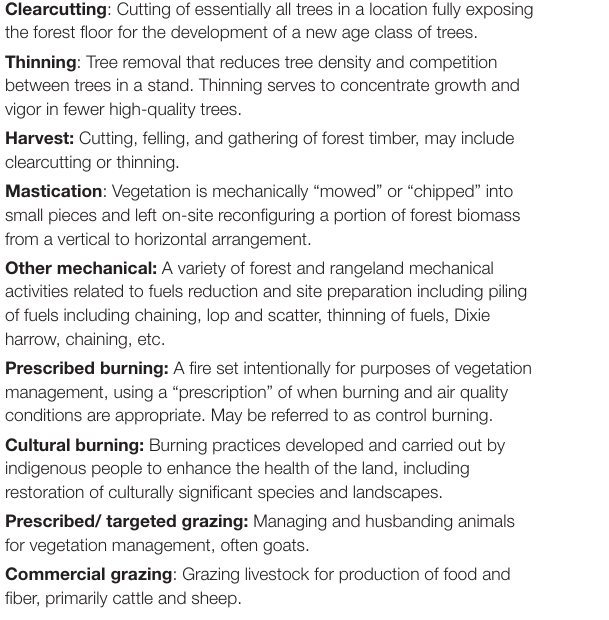
TABLE 1 | Definitions of common vegetation treatments in California. Clearcutting : Cutting of essentially all trees in a location fully exposing the forest floor for the development of a new age class of trees. Thinning : Tree removal that reduces tree density and competition between trees in a stand. Thinning serves to concentrate growth and vigor in fewer high-quality